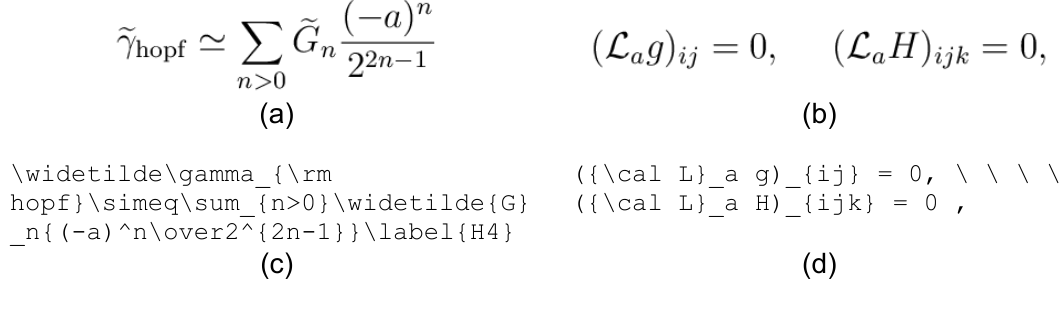
Figure 2. Two sample images of the dataset for the LaTeX decompilation task. ( a ) and ( b ) Input images. ( c ) and ( d ) Output LaTeX commands corresponding to the images. Information extracted from the public dataset: